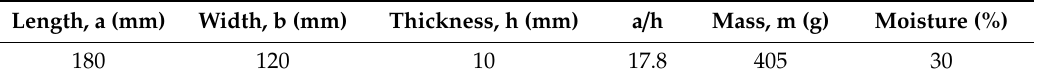
Table 1. Olive tree plate data.